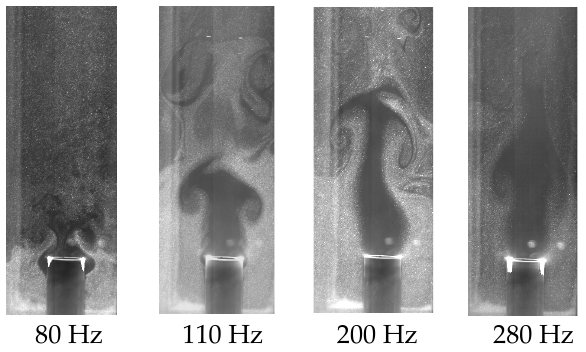
Figure 9. Mie scattering images at different frequency.